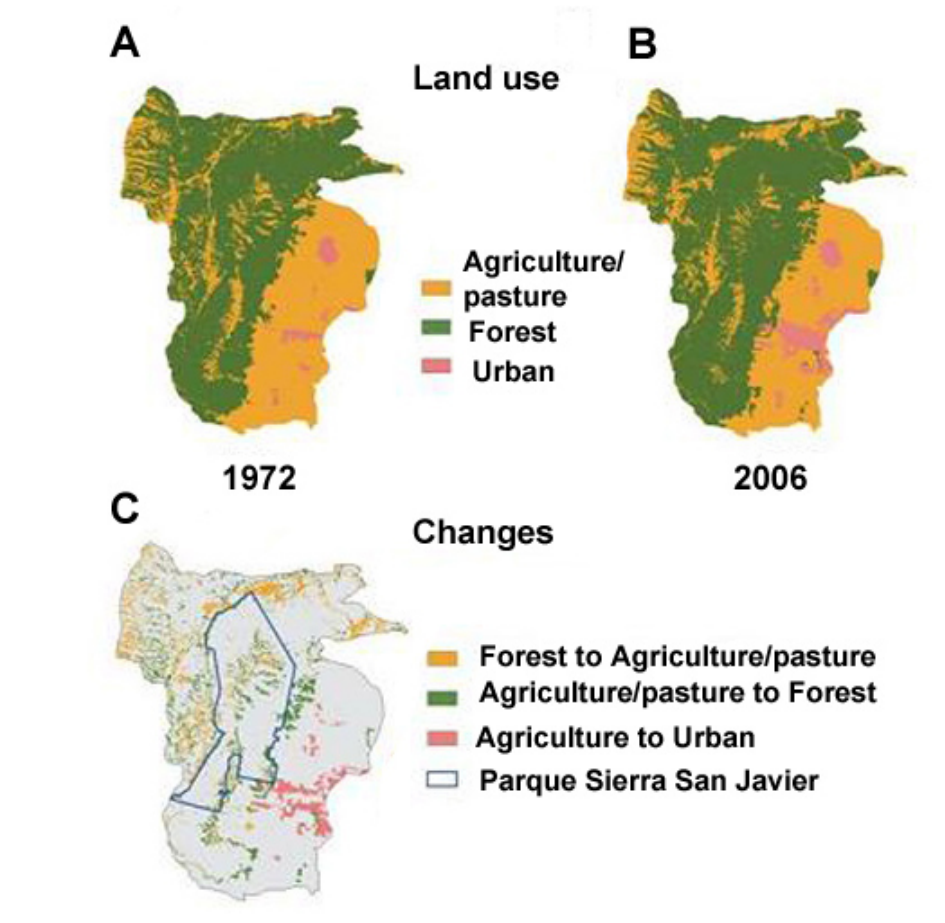
Fig. 2. Main LUC categories in 1972 (A), 2006 (B), and changes between the two dates